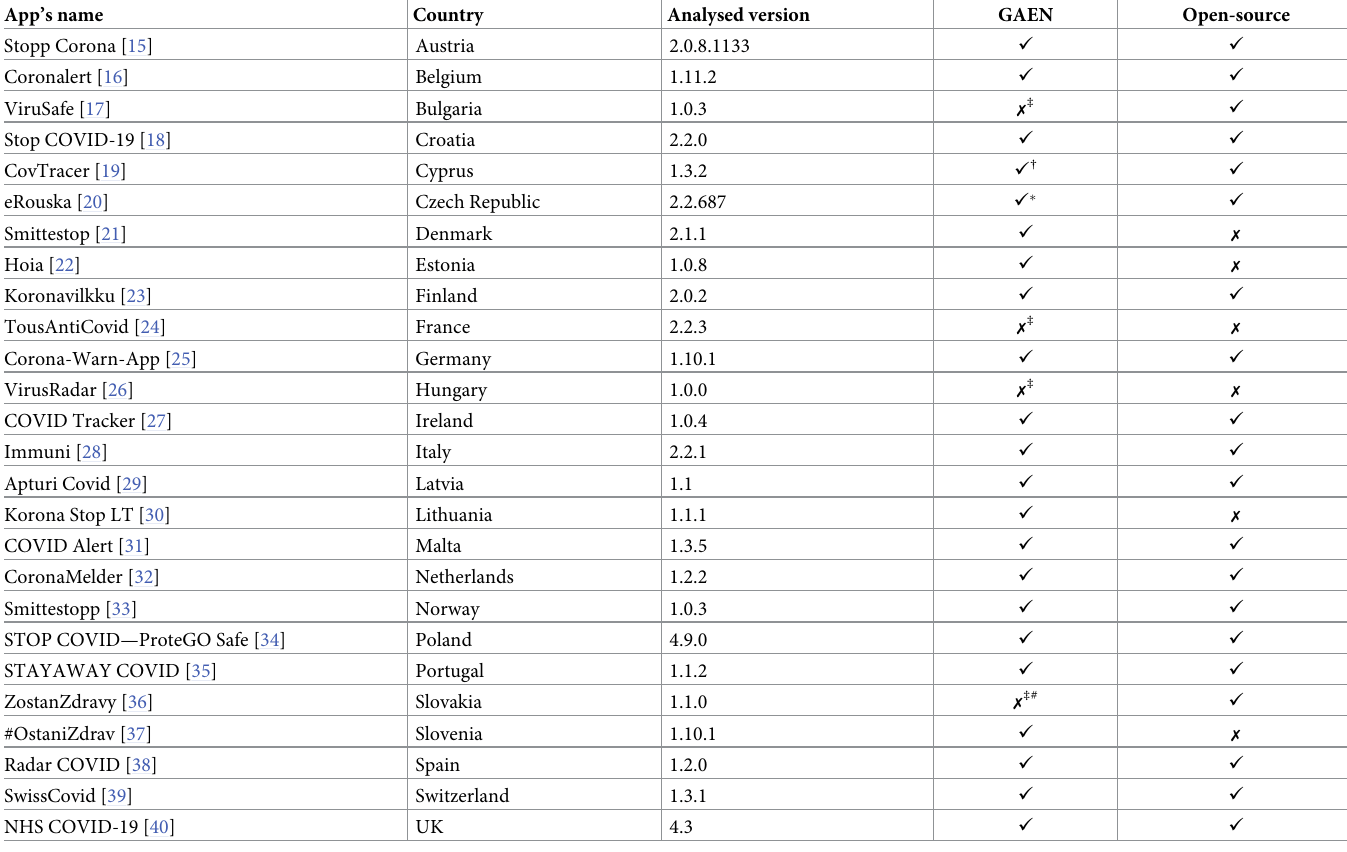
Table 1. Outline of the examined